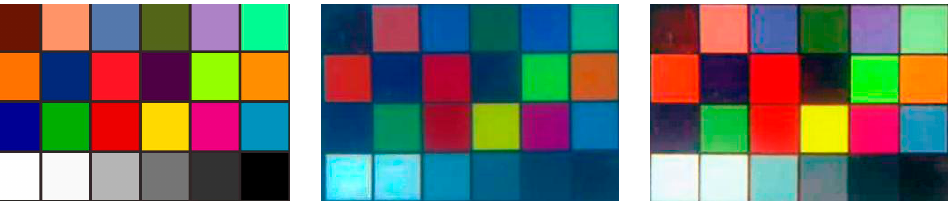
Figure 6. Comparison of the standard color checkboard, the color checkboard restored by the method in Reference [38] and that restored by BM3D filtering and color correction, which are shown from left to right.